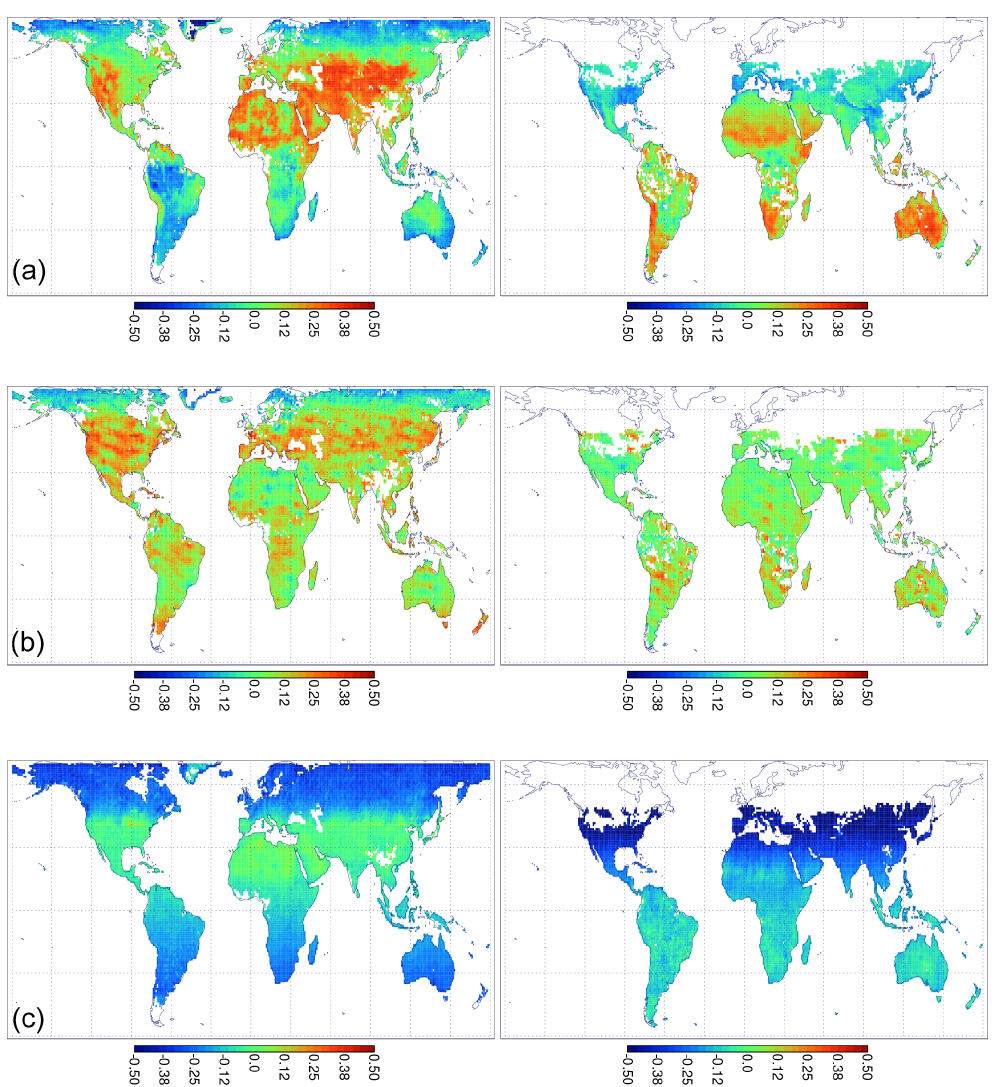
Figure 10. Global maps of the zero-level adjustment July (left) and December (right) 2007. (a) Zero-level adjustment for July (left) and December (right) 2007 for SCIAMACHY SFL red SIF retrievals inmWm − 2 nm − 1 sr − 1 (682–686.5nm). (b) Similar to (a) but for